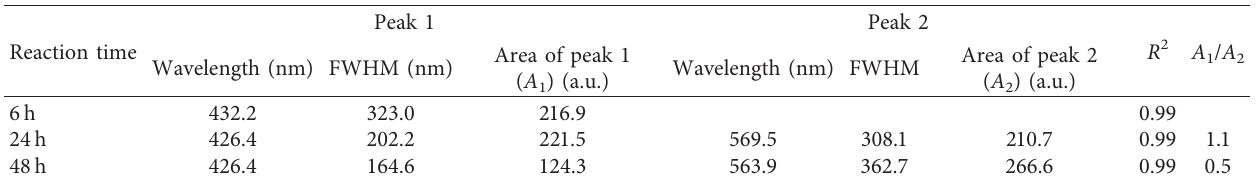
Table 1: The position, width, and area of peak 1 and peak 2 determined from Lorentz deconvolution of UV-Vis spectra of samples prepared with different reaction times.